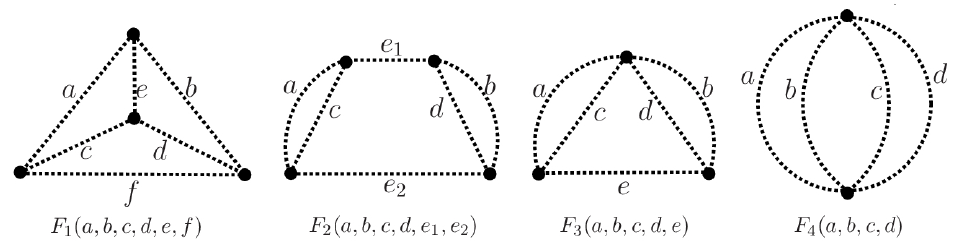
Figure 2. Four graphs F 1 ( a , b , c , d , e , f ) , F 2 ( a , b , c , d , e 1 , e 2 ) , F 3 ( a , b , c , d , e ) and F 4 ( a , b , c , d ) . Each dotted line represents a chain with the indicated